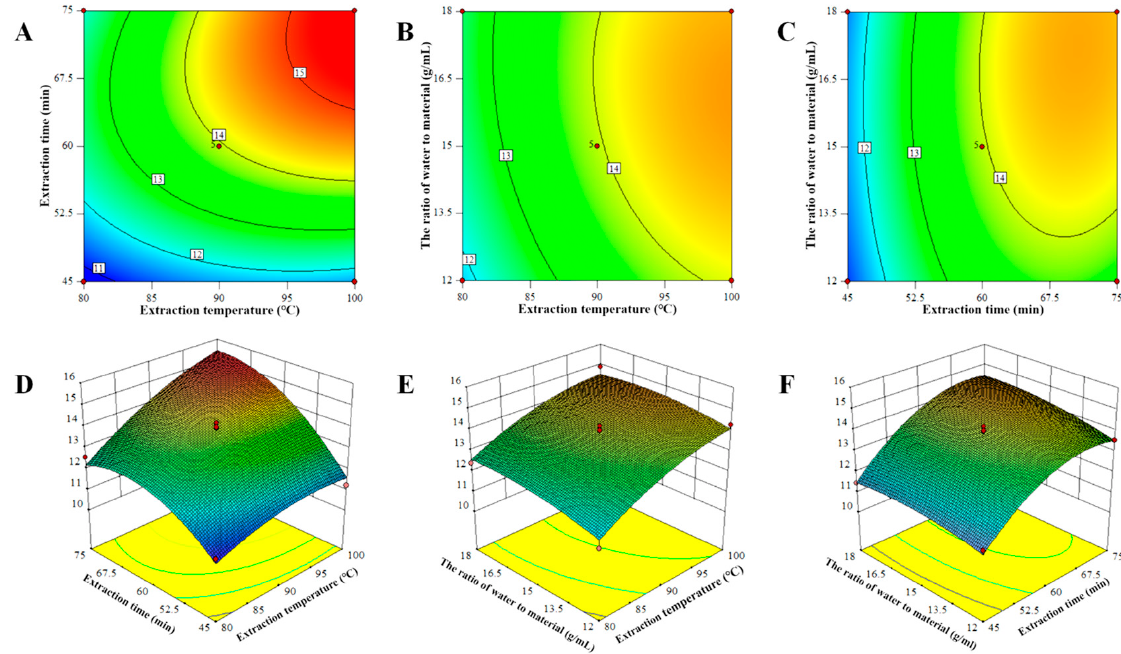
Figure 2. Three-dimensional response surface plots and two-dimensional contour plots showing the effect of interactions between variables on polysaccharide extraction yields. ( A , D ) display the influence of the extraction temperature and the time on the extraction yield of LBPs; ( B , E ) display the influence of the extraction temperature and the ratio of water to material on the extraction yield of LBPs; ( C , F ) display the influence of the time and the ratio of water to material on the extraction yield of LBPs